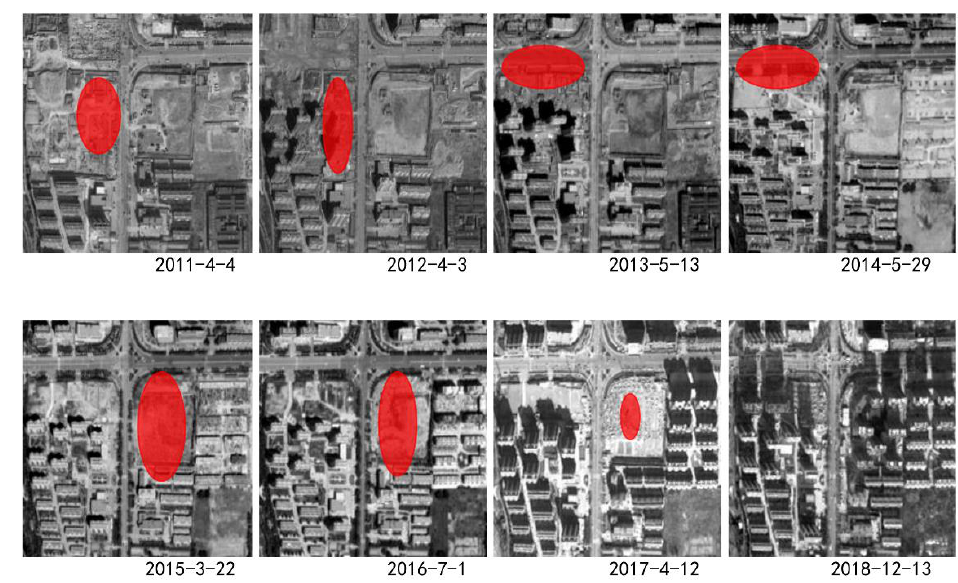
Figure 7. Evolution process of Sun Jia fairs in 2011–2018 (Source: Own drawing).